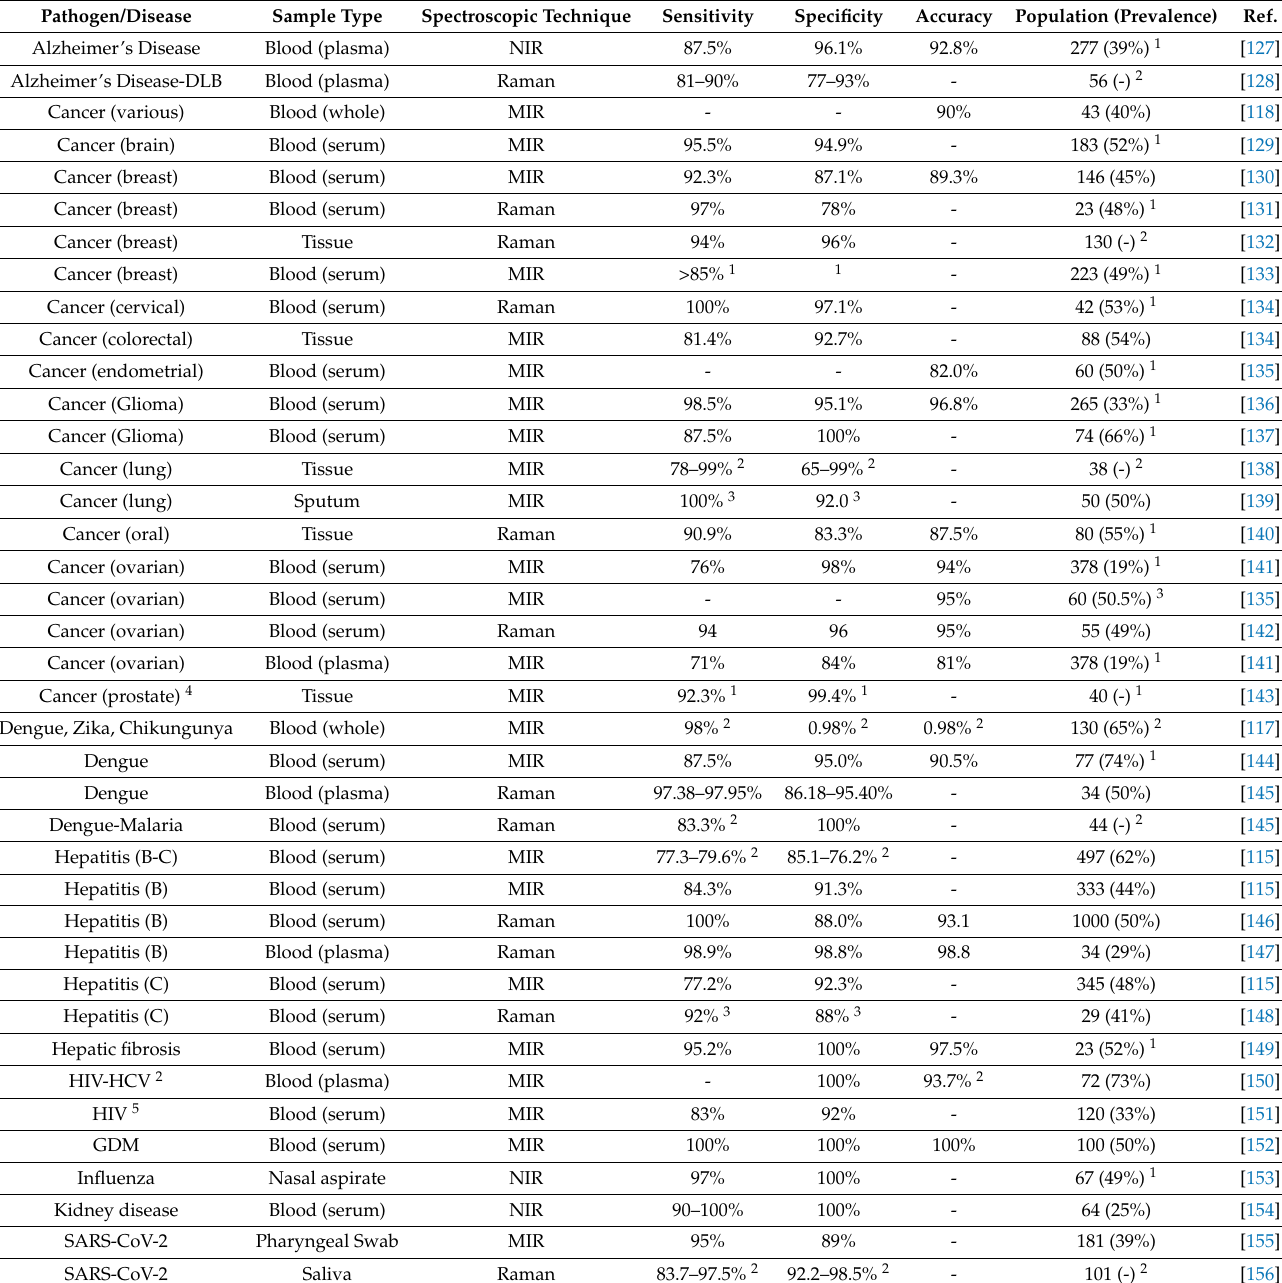
Table 1. The reported performance of a selection of vibrational-spectroscopy-based detectors for the detection of several pathogens. Due to the slight differences in metric definitions and computations among groups, the reported performances are not directly comparable among techniques and diseases. Thus, the information contained in this table is not to compare the different methodologies but rather to provide an overall figure of merit of the potential and capabilities of these techniques for the detection of a variety